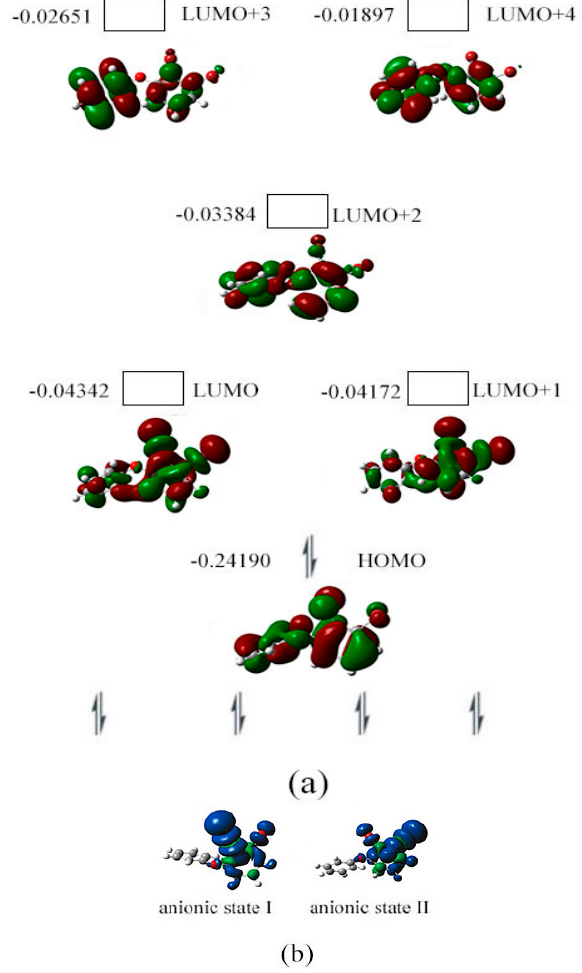
Figure 4. Orbital energy (hartree), HOMO, LUMO ( a ) iso-surface value = 0.02 au, degeneracy threshold = 0.01 hartree) for BDE-5 and its spin density ( b ) iso-surface value = 0.0004 au) surface image in gas phase.